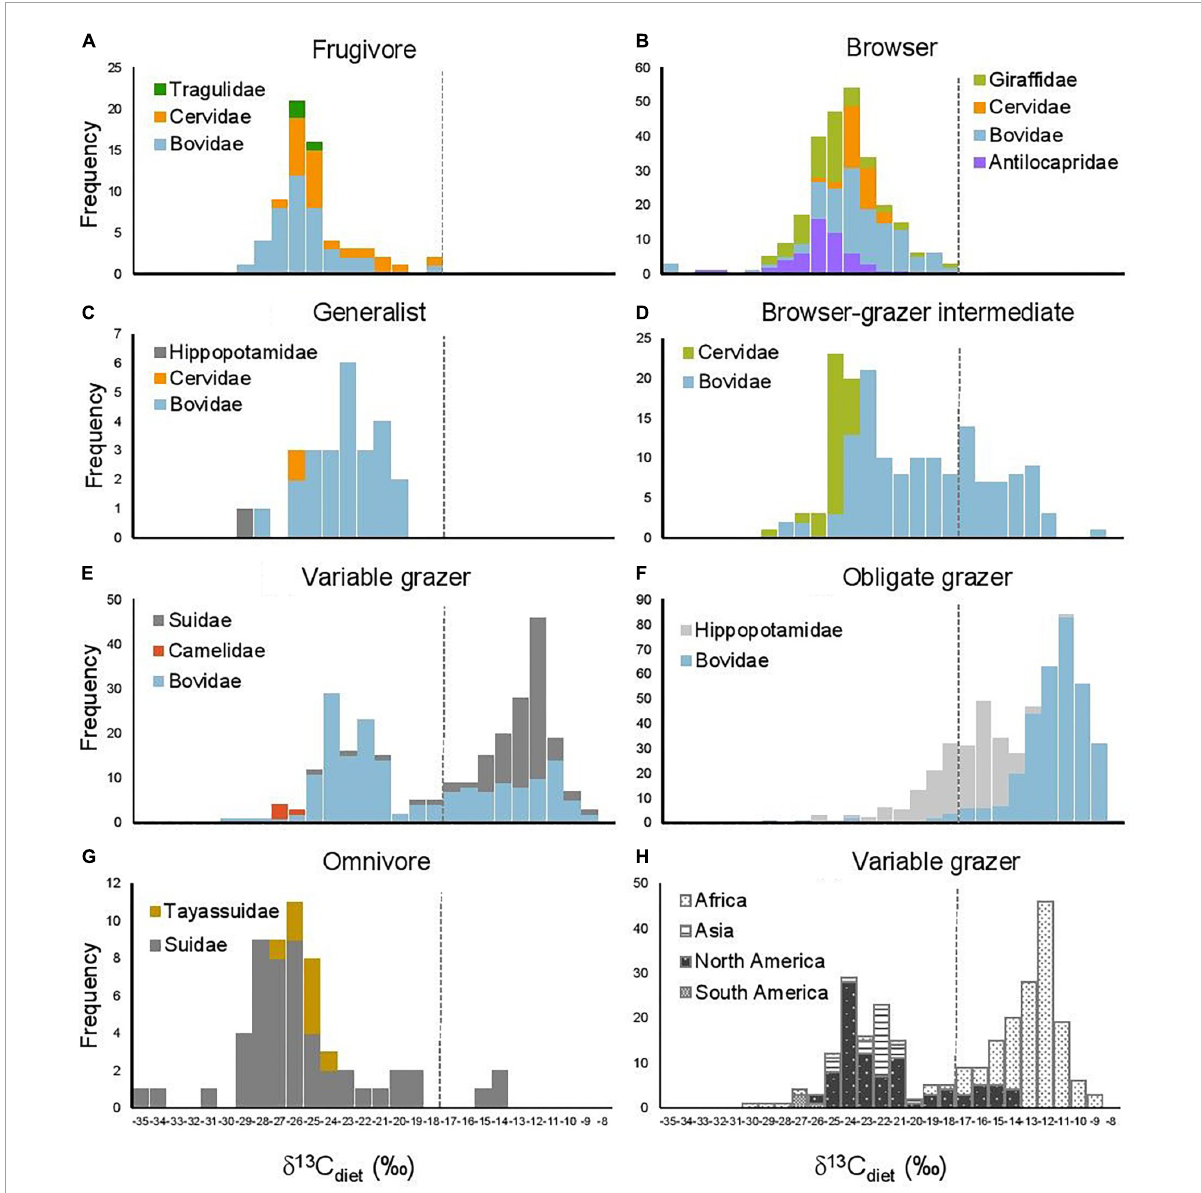
FIGURE3 Histograms of δ 13 C diet values in seven artiodactyl feeding categories in relation to (A–G) taxonomic group and (H) continent. Dashed line is the C 3 -C 4